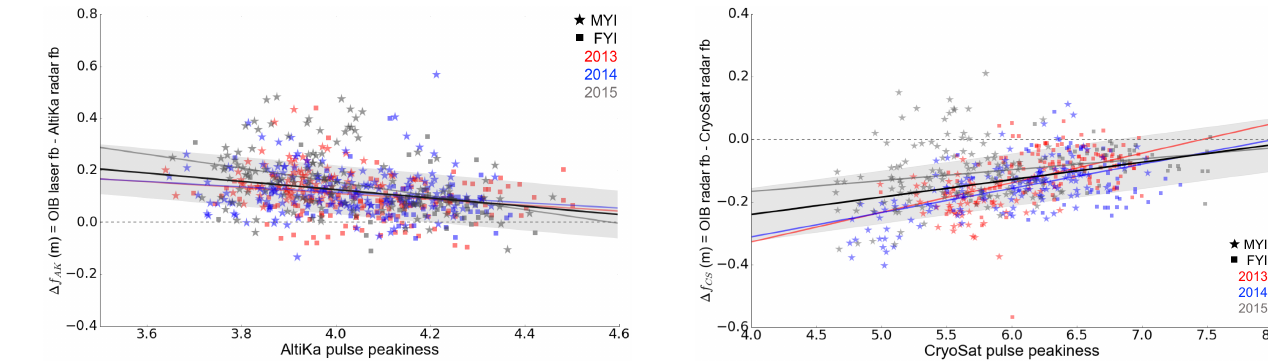
Figure 1. The value (cid:49)f AK , defined as the OIB laser freeboard mi- nus the AltiKa radar freeboard, plotted against AltiKa pulse peaki- ness, for the OIB spring campaigns of 2013 (red), 2014 (blue), and 2015 (grey). Multi-year and first-year ice are plotted with stars and squares respectively, and the horizontal grey dashed line marks zero. The combined (all years) linear regression fit (CLRF), shown by the black line, has a slope of − 0 . 16 and an intercept of 0.76. The shaded area around the CLRF shows the 68% prediction interval, corresponding to a standard error (SE) on (cid:49)f AK of 9.4cm. Please note that fb is freeboard.